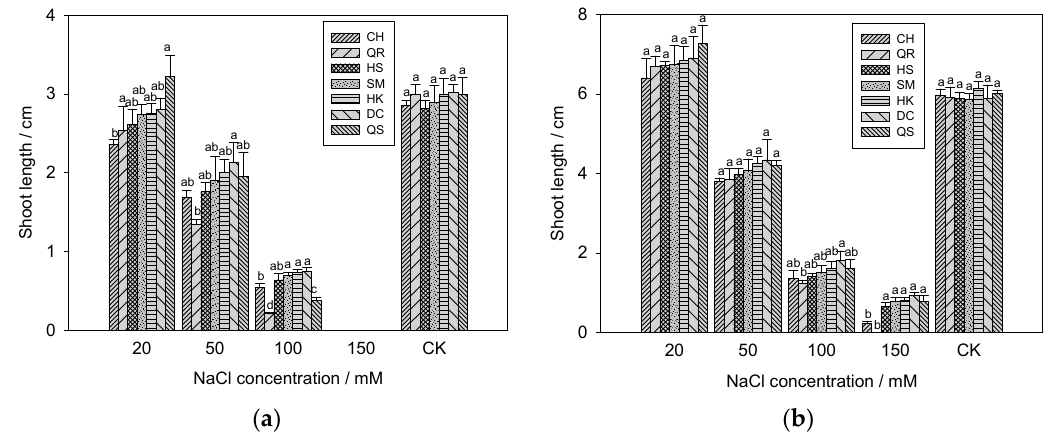
Figure 2. The shoot length (cm) of E. crus ‐ galli with four NaCl concentrations at different time points. The shoot length (cm) of E. crus ‐ galli under four NaCl concentrations at 4 days ( a ) and 7 days ( b ) after treatment. Lowercase letters are expressed as least square means ± standard error ( p < 0.05).